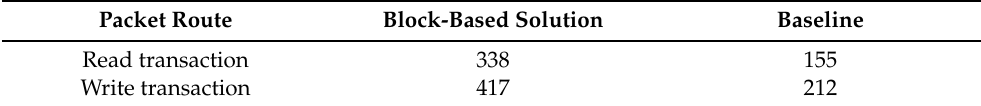
Figure 10. Evaluation of Write time overhead. Table 1. Packet overhead evaluation (in